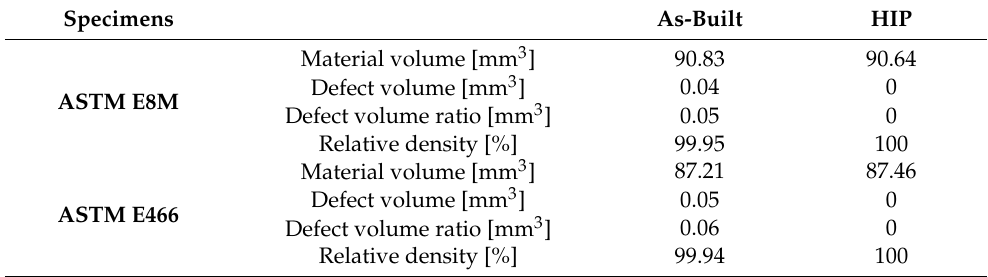
Table 4. Relative density of the specimens for the mechanical tests in the as-built and HIP state. Specimens